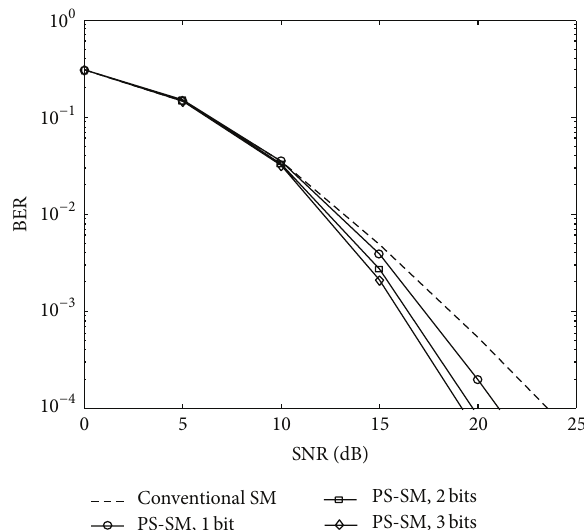
Figure 4: Performance of PS-SM with different feedback amounts on 4 × 2 MIMO channels.